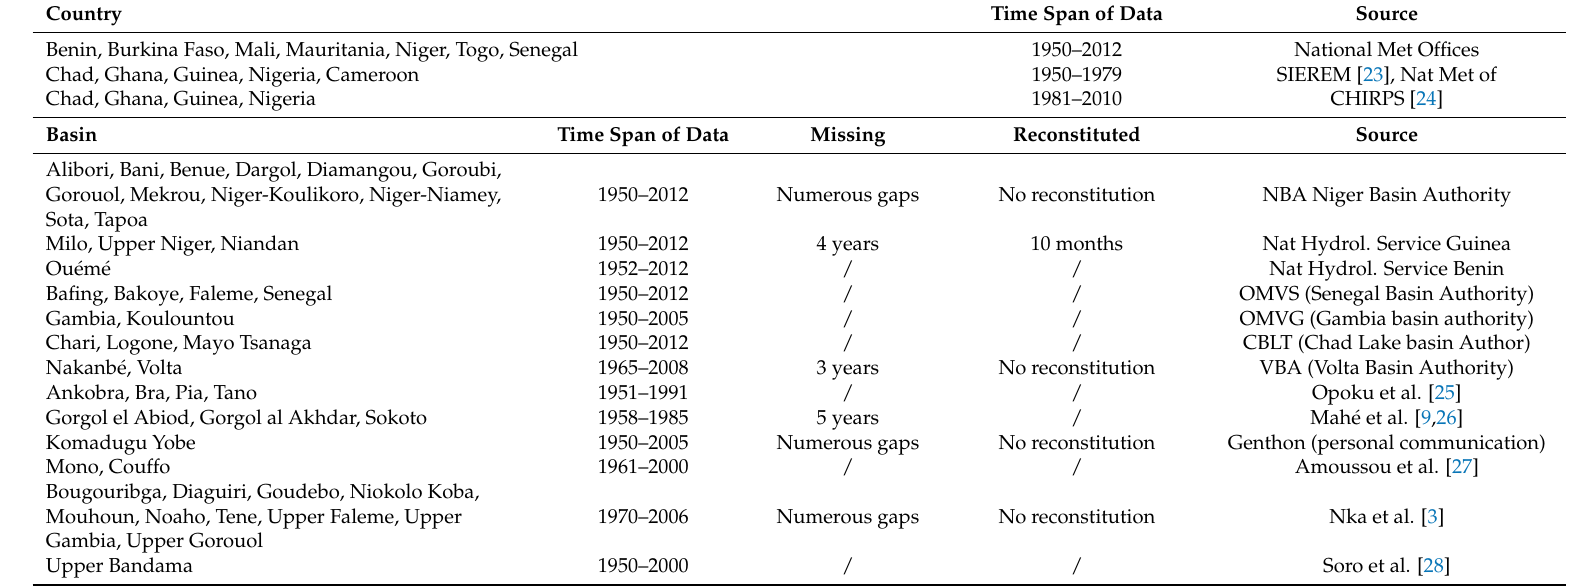
Table 1. Description of data set; top: rainfall data; bottom: runoff coefficient